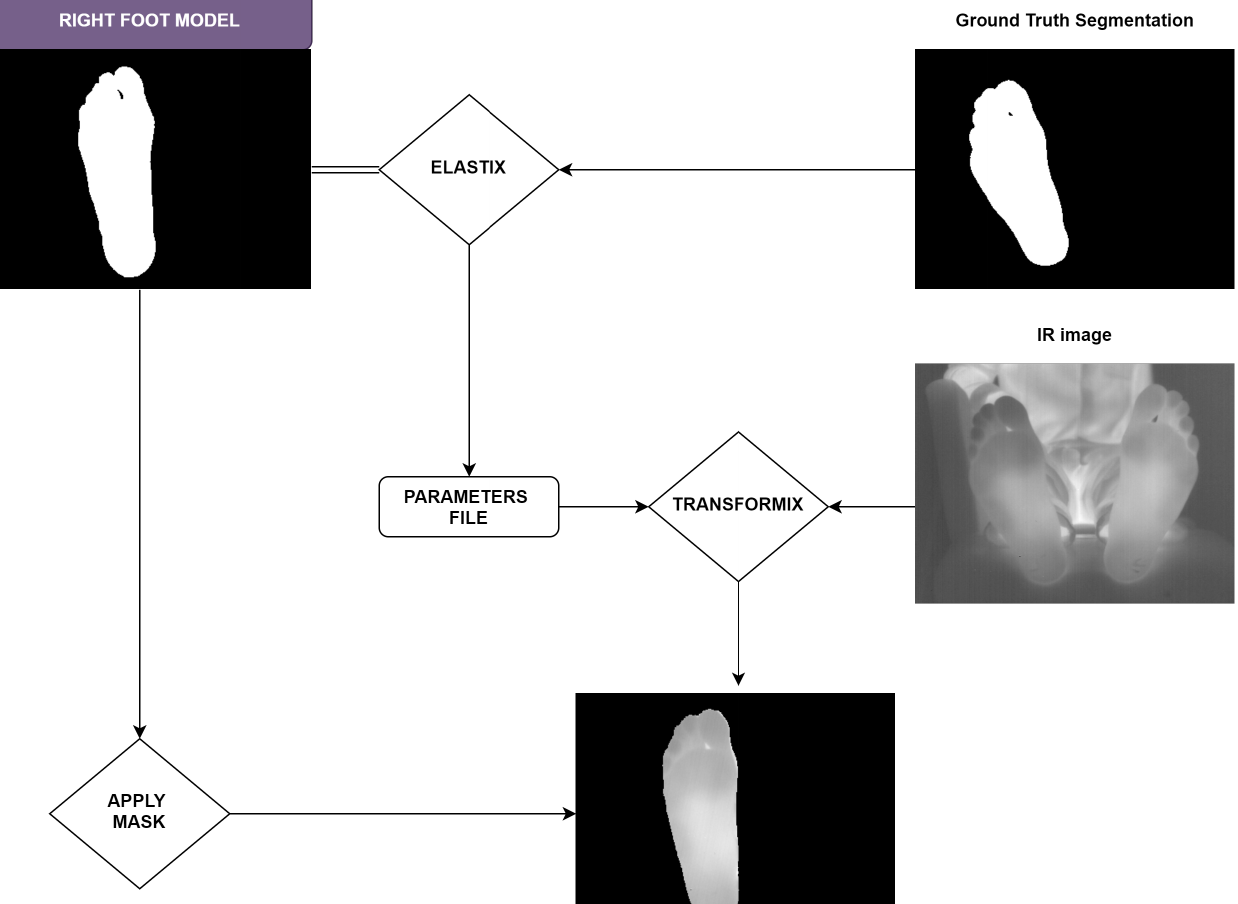
Figure 2. Workflow employed to apply the right foot model to the acquired IR image. An analogous workflow is employed for the left